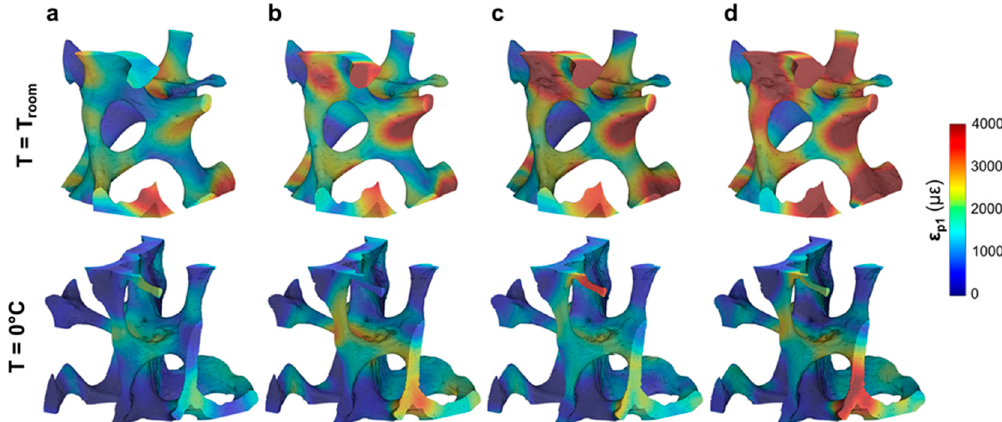
Figure 6. Three-dimensional full-field first principal strain ( ε p1 ) distribution in trabecular bone tissue imaged at room temperature (top) and 0 °C (bottom) after the acquisition of ( a ) two, ( b ) three, ( c ) four and ( d ) five consecutive tomograms. A representative cube (~1 mm 3 ) in the centre of the analysed VOI is represented.